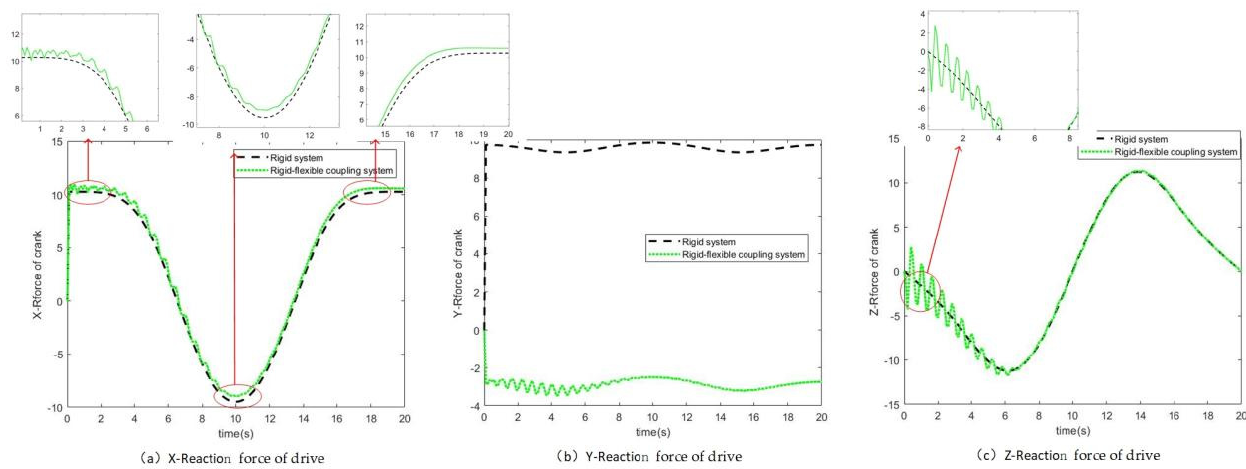
Figure 8. Reaction force of drive.